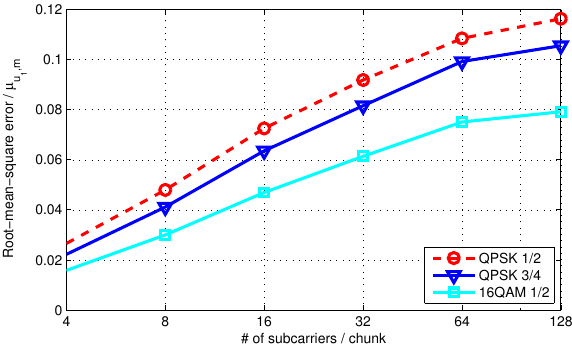
Figure 6. RMSE of µ u at i = 1, caused by the approximation (25). 1 , m